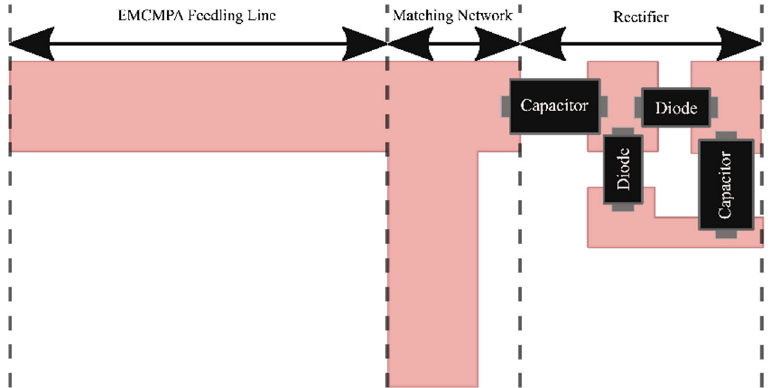
Figure 9. Electromagnetically coupled microstrip patch feeding line, matching network and recti- fier layout.